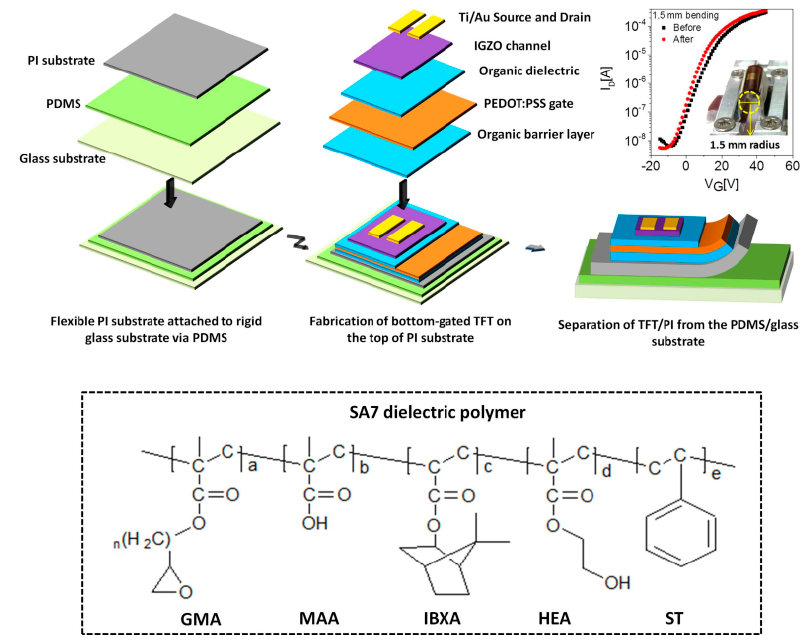
Figure 8. The fabrication process for IGZO TFTs (top left). Transfer curve of IGZO TFT under bending stress (top right corner). Chemical structure of SA7 [160] (dotted box).